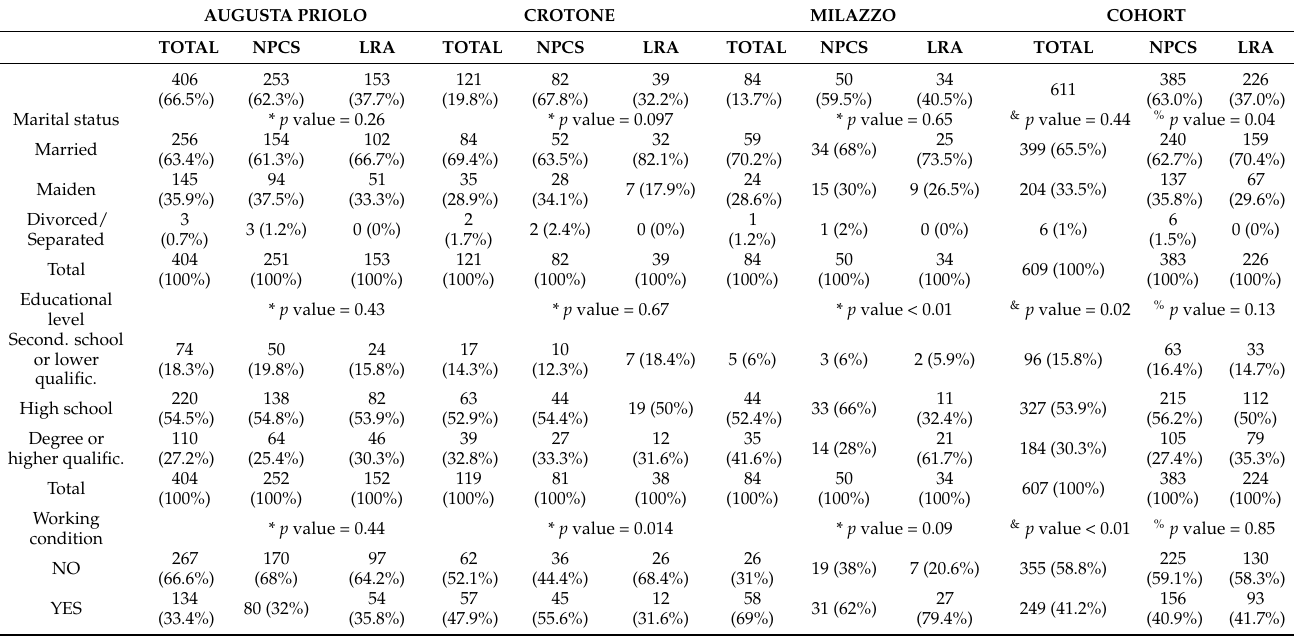
Table 2. Descriptive characteristics of participants to the Neonatal Environment and Health Outcomes birth cohort: lifestyle and